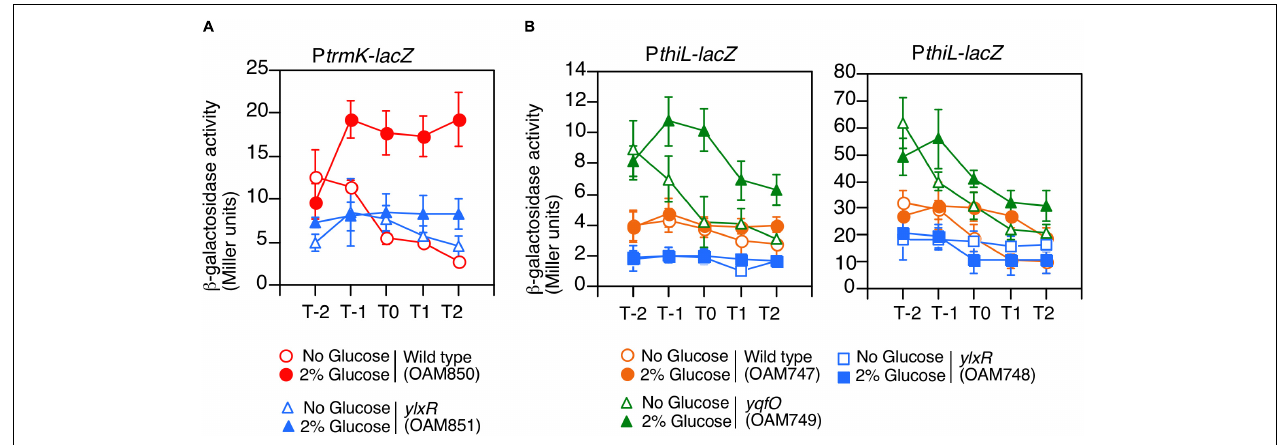
FIGURE 4 | Expression of P trmK-lacZ and P thiL-lacZ . Means of the β -Gal activities from three independent experiments and the standard deviations are shown. The x axis is the same as in the legend to Figure 1 . (A) P trmK-lacZ . (B) P thiL-lacZ . β -galactosidase activities measured using CRPG (right) instead of ONPG (left) as a substrate are